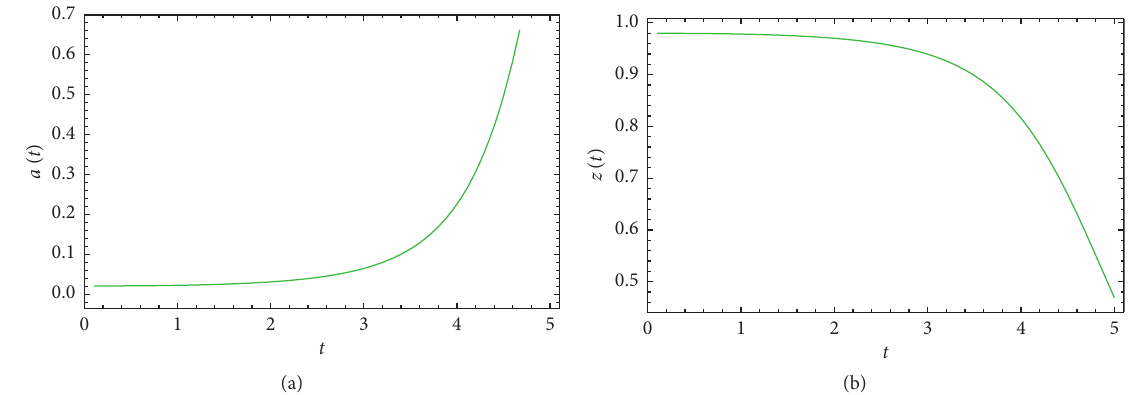
Figure 10: Evolution of the scale factor and red shift function for ω β � − 0 . 04858 ; λ � 0 . 5 ; r � − 0 . 0005 ; s � 5.